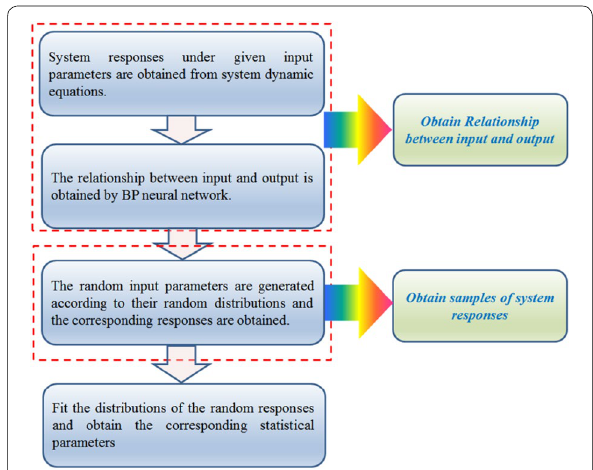
Figure 5 Flowchart for distribution fitting of system dynamic